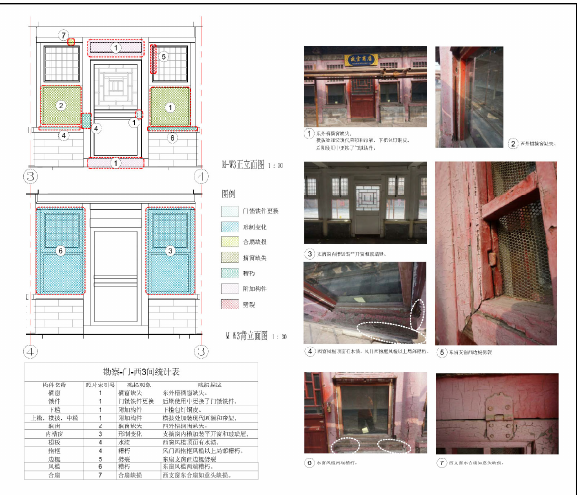
Figure 23 Thematic drawing for windows and doors, with shadow 2D